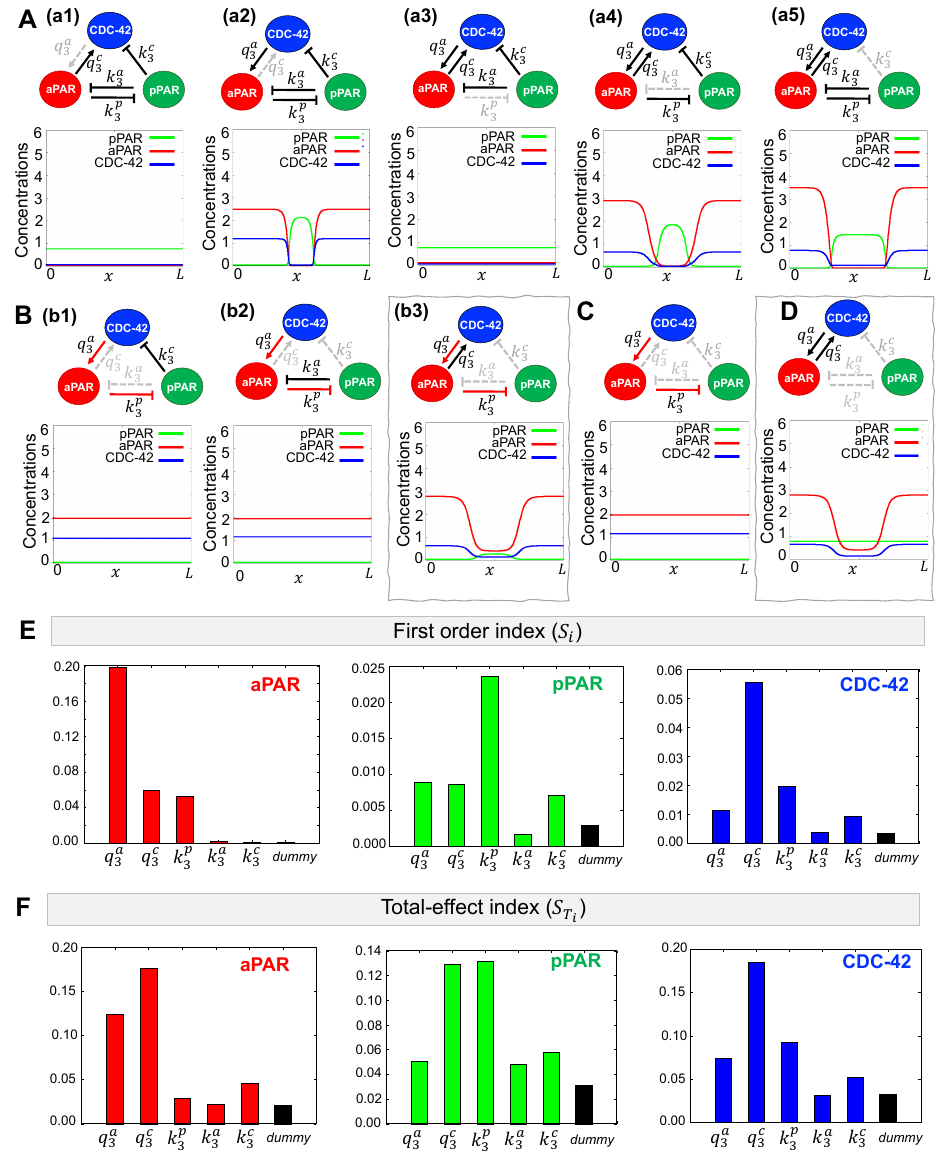
Figure 3. Minimal network needed for maintenance of Par protein polarization. ( A – D ) Representative simulations for the effects of network interactions. Dotted gray lines indicate interactions excluded from the network. Simulations are shown at t = 16 min, the approximate amount of time the early C. elegans embryo spends in the maintenance phase [33]. Initial conditions are given by the corresponding stationary solution (Figure 2B). ( A ) (a1)–(a5) Simulation results of networks omitting a single interaction. Minimal networks that produce the correct spatial pattern and are retained for further analysis are boxed in gray. ( B ) Red arrows indicate interactions identified in ( A ) that are retained in these additional networks. (b1)–(b3) Simulation results of networks omitting two interactions. ( E , F ) Variance-based sensitivity analysis results using eFAST. Parameters with higher values have a more significant effect on the network dynamics. ( E ) The first order index (the effect of a parameter on the model dynamics independent of the other parameters) and ( F ) The total effect index (the effect of a parameter including the interactions with other all model parameters) both indicate that CDC-42 interactions with aPAR are critical for producing the correct spatial